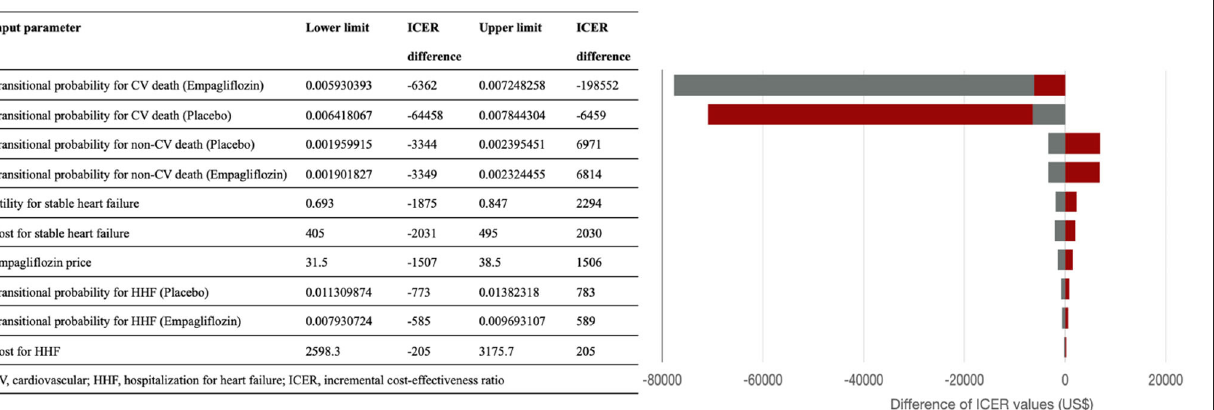
FIGURE 2 | The tornado diagram presents the results of one-way sensitivity analysis. The red and gray bar represent the corresponding incremental cost-effective ratio values when the lower and upper limits of the parameters were used. ICER, incremental cost-effectiveness ratio; CV, cardiovascular; HHF, Hospitalization for heart failure.